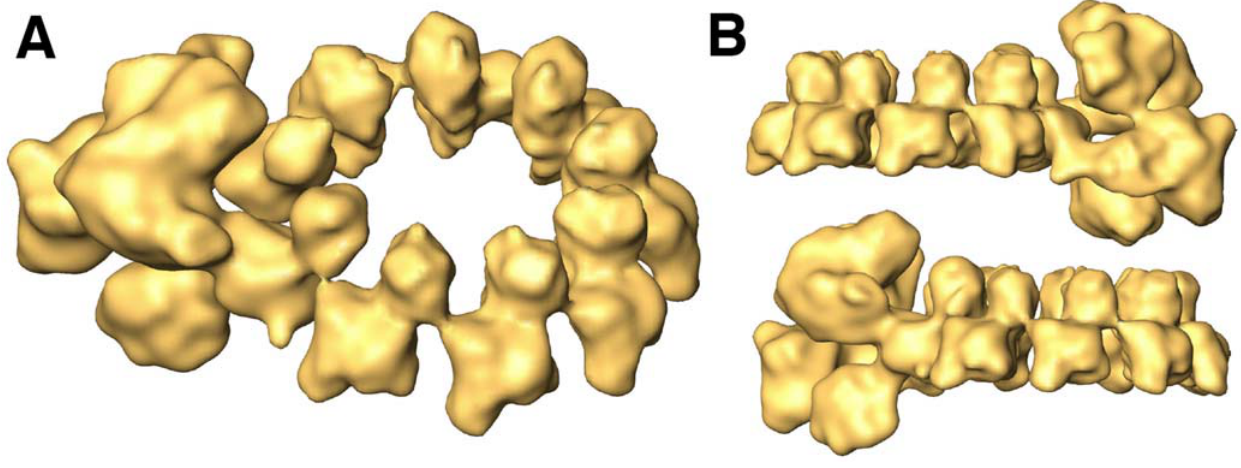
Figure 2. Three-dimensional model of a recombinant virus mini-RNP. The final volume is a chimera containing the polymerase and two adjacent NP monomers derived from a non-symmetrical volume and the rest of the NP ring derived from the symmetrical volume (see Fig. S2). (A) Perspective view of the composite three-dimensional structure for the recombinant RNP. (B) Side views.